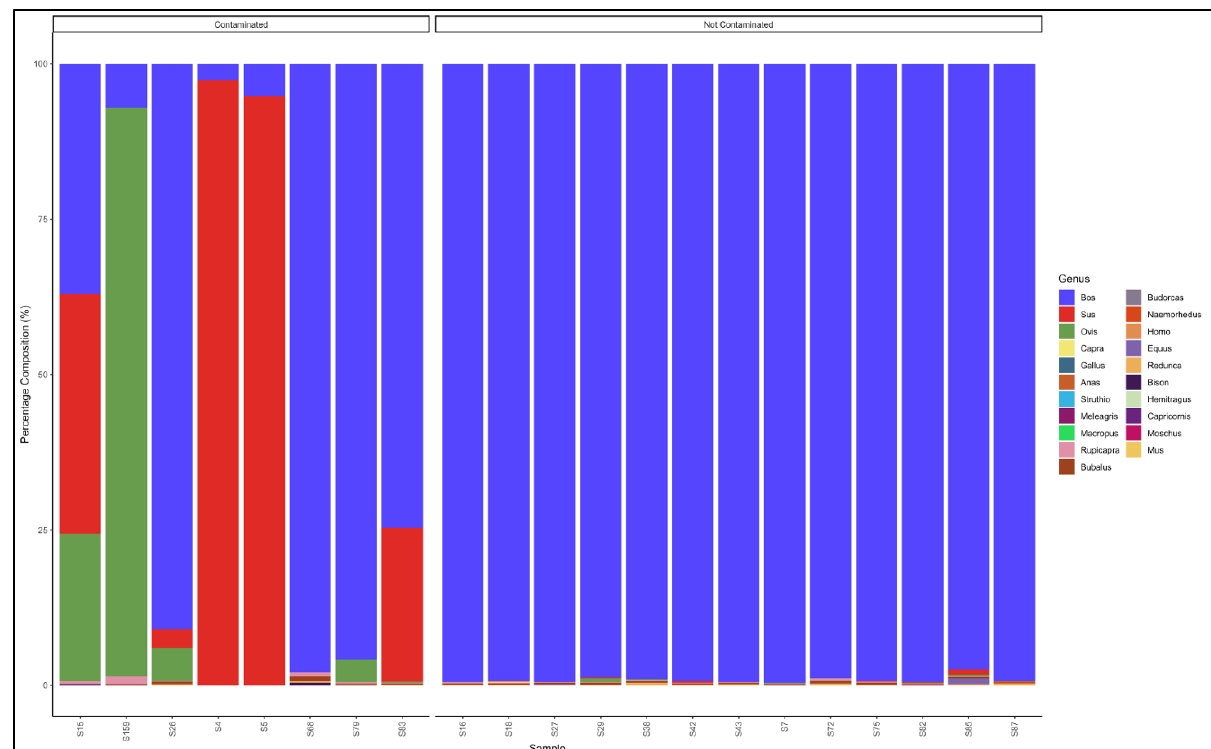
Figure 11. Percentage composition of samples labeled as beef sausages.